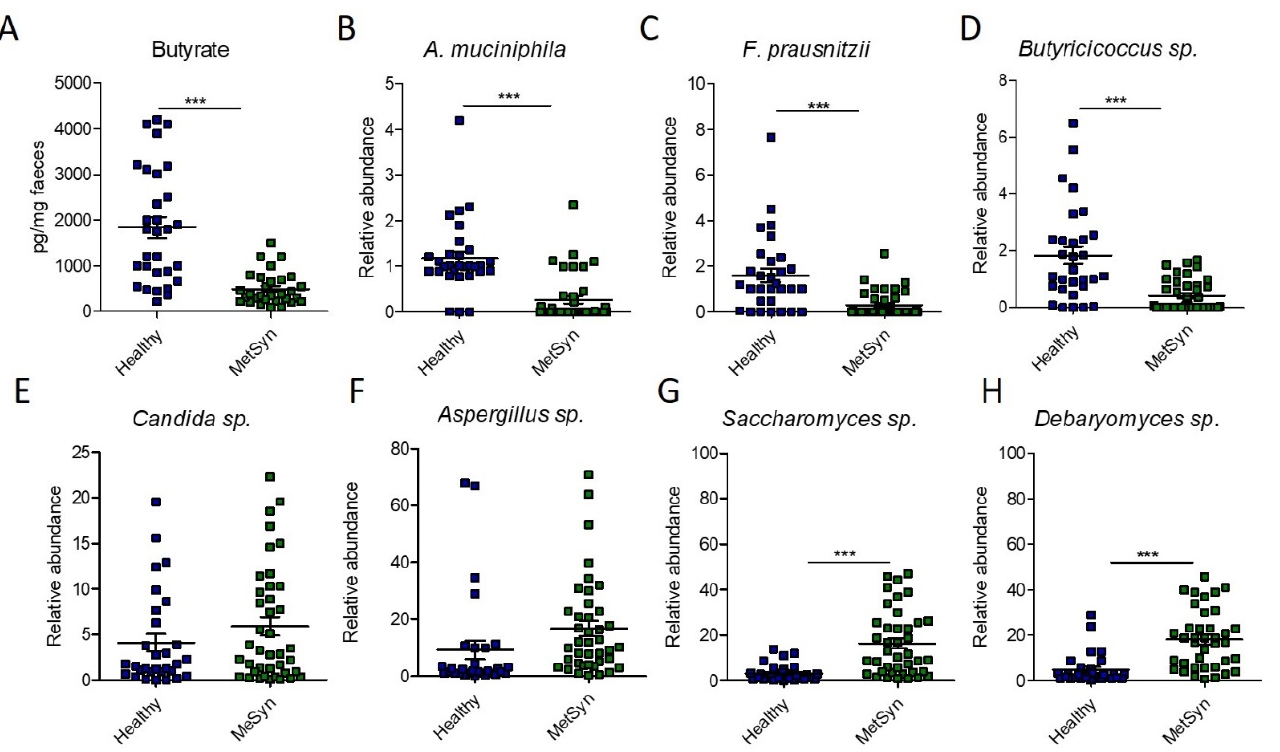
Figure 3. Microbiome changes in MetSyn patients ( n = 40) versus healthy controls ( n = 30). ( A ) Bu- tyrate quantification in faecal samples; The relative abundance of A. muciniphila ( B ), F. praunsitzii ( C ), Butiricicoccus spp. ( D ), Candida spp. ( E ), Aspergillu spp. ( F ), Saccharomyces sp. ( G ), and Debaryomyces spp. ( H ) in faecal samples collected from healthy individuals and MetSyn patients; *** p < 0.0001, Mann–Whitney test.